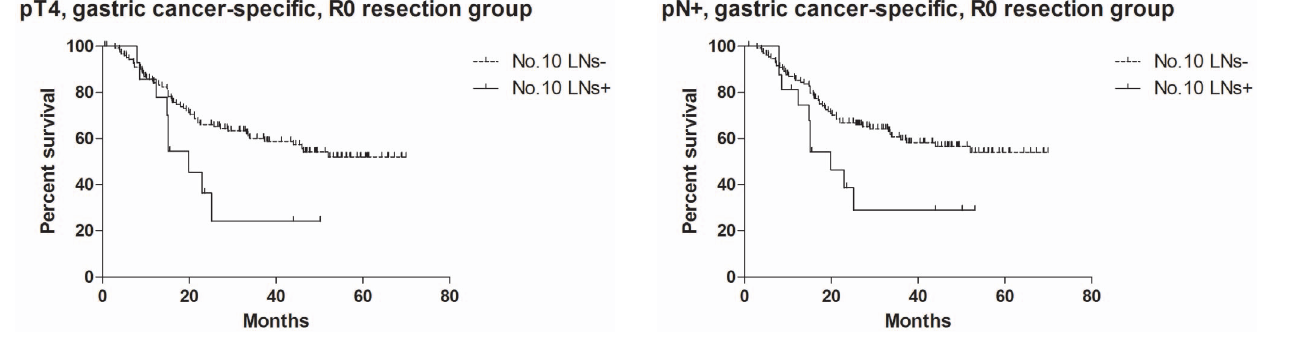
Figure 9. Kaplan-Meier survival analysis of pN + stage gastric cancer specific + R0 resection group in all patients.